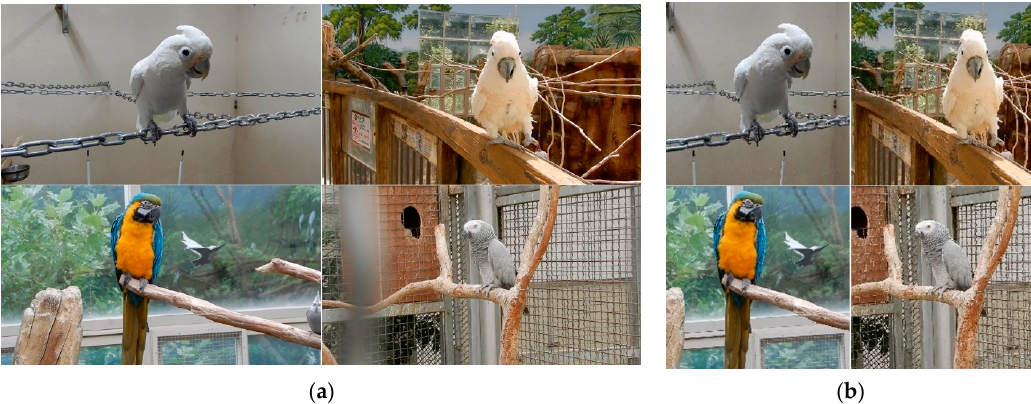
Figure 1. Examples of preprocessing. ( a ) before image resizing (1920 × 1080 pixel resolution), ( b ) after image resizing (300 × 300 pixel resolution).